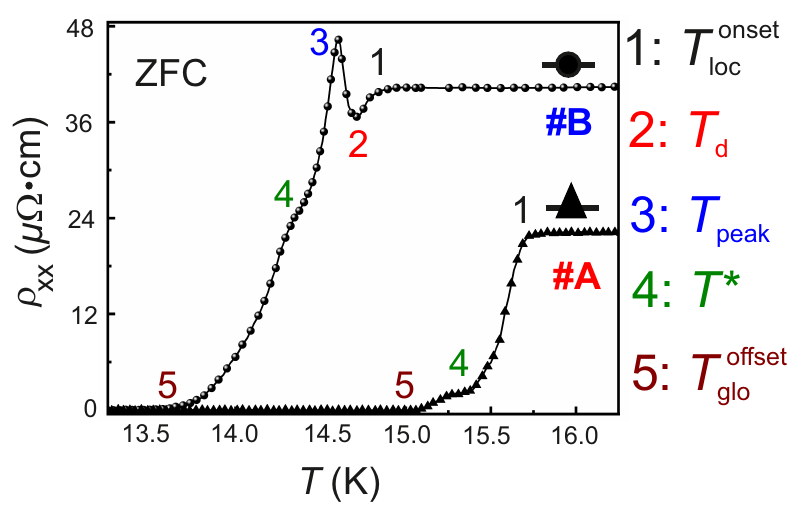
Figure 2. ZFC ρ xx as a function of T for samples #A and